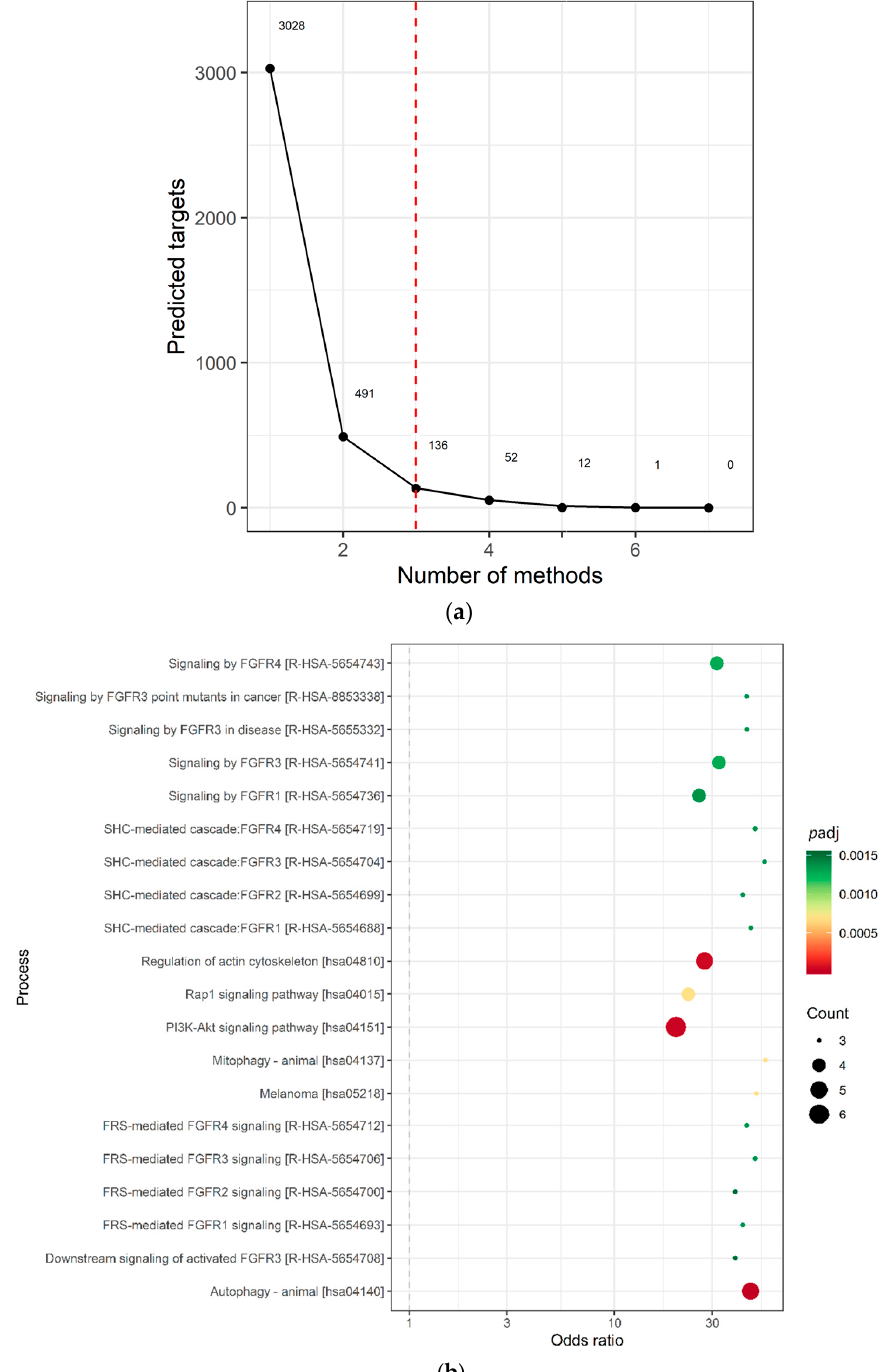
Figure 2. miRNA target prediction and pathway analysis. ( a ) Number of consistent target gene pre- dictions for miRNAs specifically expressed in AYA T-ALL in relation to the number of prediction algorithms used. ( b ) Processes and pathways potentially affected by miRNAs specifically expressed in AYA T-ALL, revealed by overrepresentation analysis. The plot presents odds ratios for the se- lected terms, identified using conditional hypergeometric test, with Benjamini and Hochberg cor- rection for multiple testing and 0.05 significance level. The size of the dots (Count) represents the number of genes (predicted targets of the studied miRNAs) involved in a given biological process; the color of the dots represents p value ( p adj) adjusted for multiple testing.